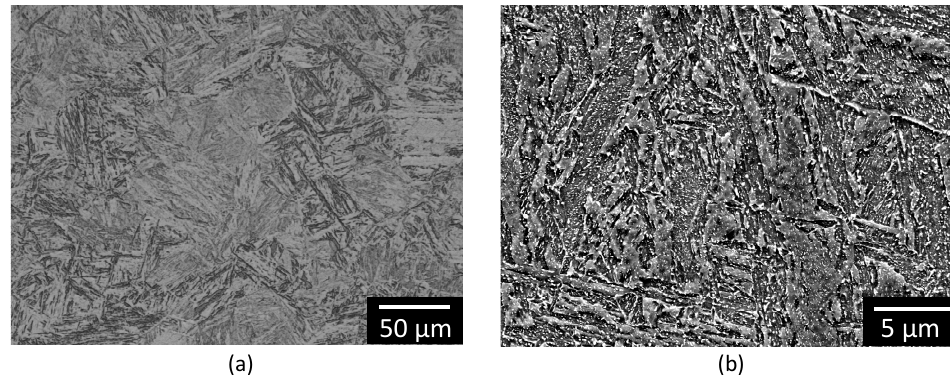
Figure 1. Representative images of the microstructure of 27NiCrMoV15-6 steam turbine steel ( a ) light optical microscopy (LOM) image, ( b ) scanning electron microscopy (SEM) image.